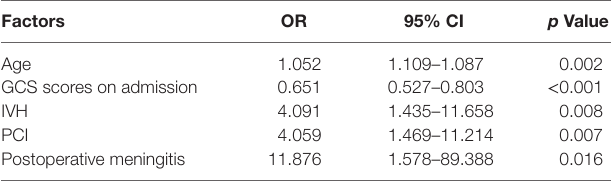
Table 2 | Multiple logistic regression model for factors associated with